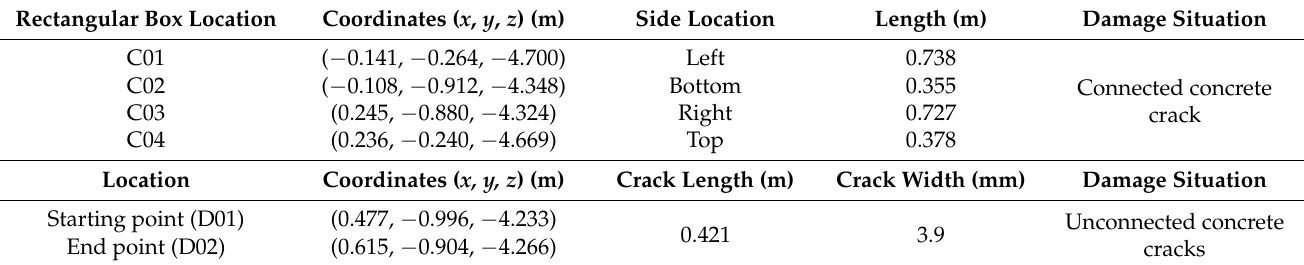
Table 5. Analyses of the damage at the bottom of the main